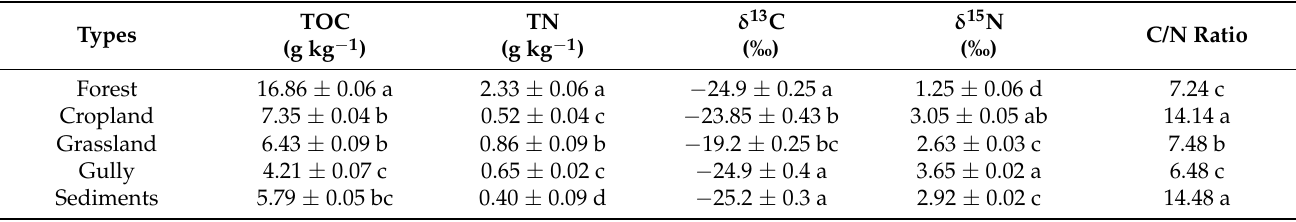
Table 2. Measurement of total organic carbon (TOC), total nitrogen (TN), C:N ratio and stable isotope composition in various source soils and sediments.